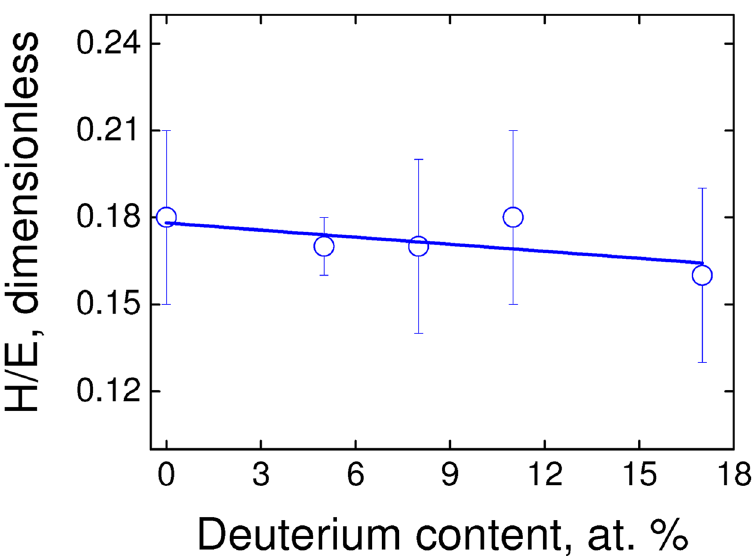
Figure 4. H/E ratio as a function of the deuterium content in the a-C:D/H thin films (isotopic